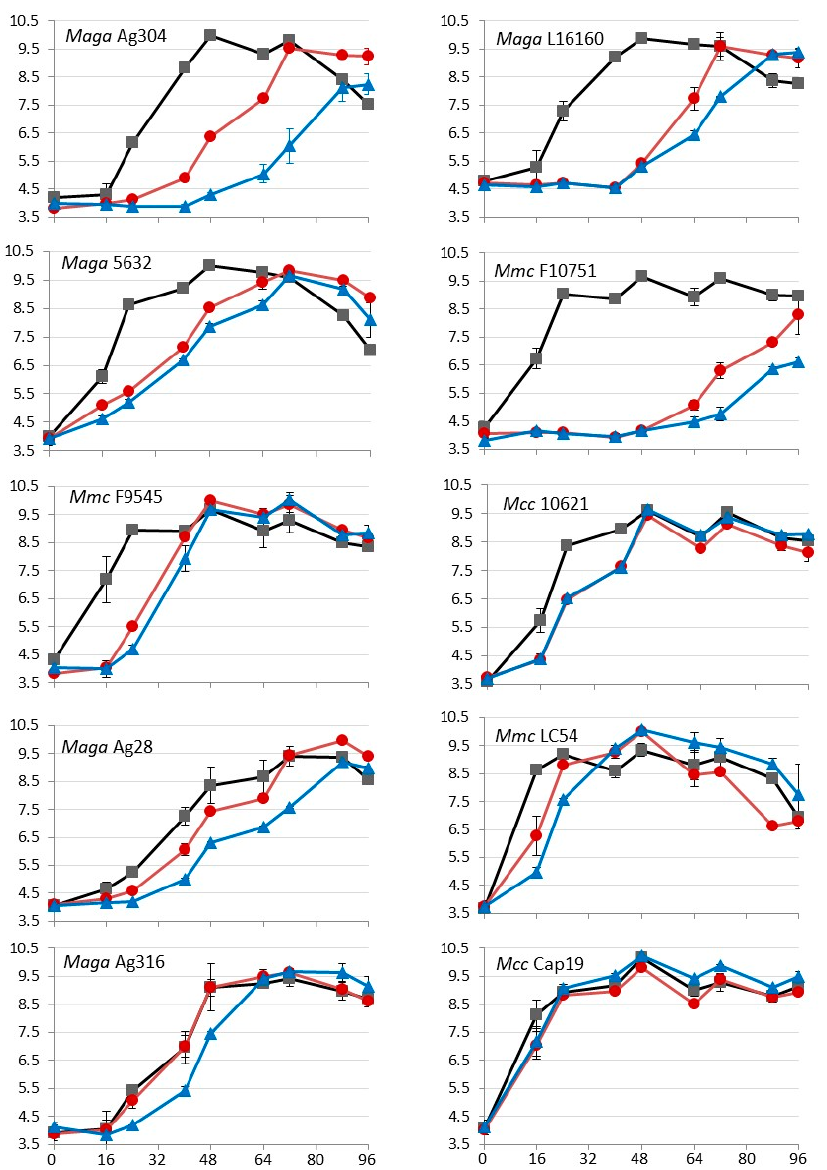
Figure 3. Growth kinetics of M. mycoides subsp. capri , M. capricolum subsp. Capricolum, and M. agalactiae strains obtained under different culture conditions: broth medium only (black curves), broth medium with oxytetracycline (red curves), and broth medium with oxytetracycline and reserpine at 20 µg/mL (blue curves). The specific concentrations of oxytetracyline corresponded to ¼ of the MIC per strain (i.e., 0.0625 µg/mL for Mcc Cap19; 0.5 µg/mL for Maga Ag204, Maga 5632, Mcc 10621, Mmc LC54; 1 µg/mL for Maga L16160, Mmc F10751, Mmc F9545, Maga Ag28 and 2 µg/mL for Maga Ag316). Reserpine was added at 20 µg/mL (blue curves); x -axis: incubation time (in hours) and y - axis: bacterial counts (in log10 cfu/mL).